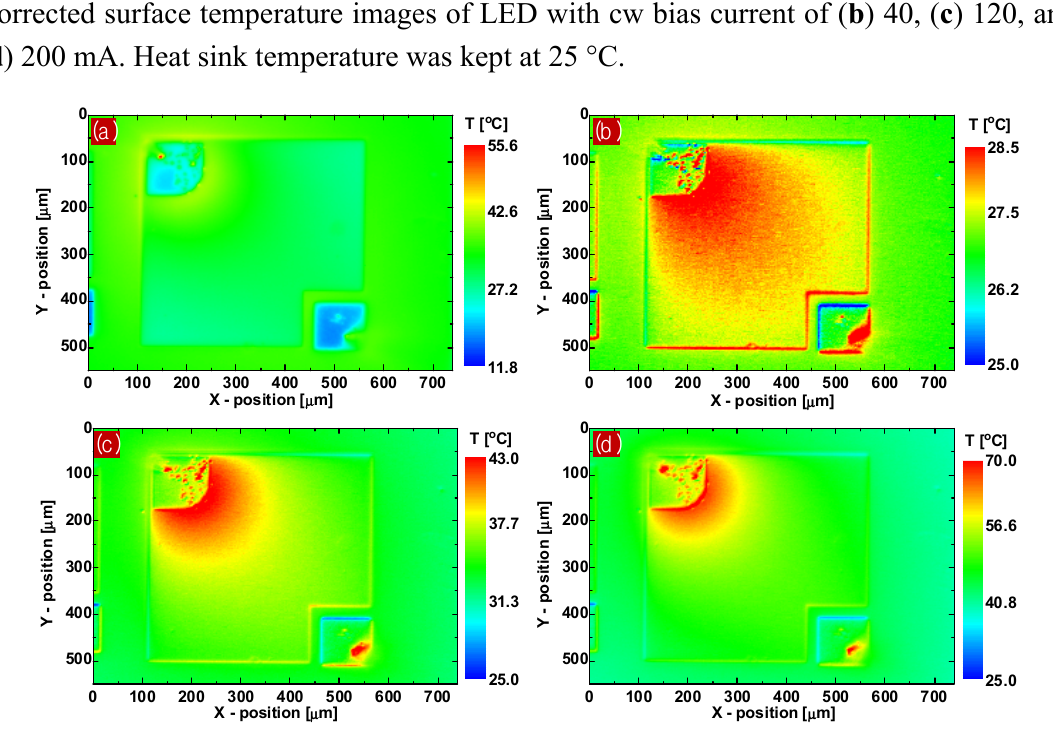
Figure 9. ( a ) Uncorrected raw temperature image of LED with cw bias current of 200